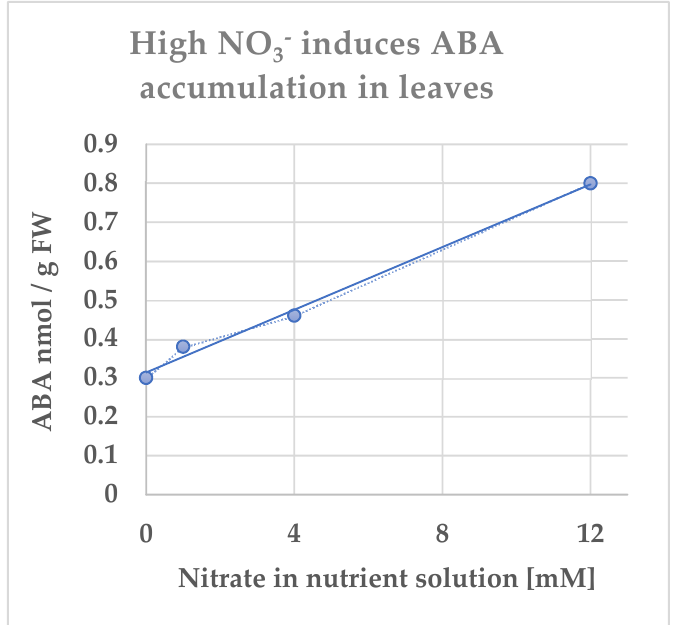
Figure 1. Concentration of ABA per fresh weight of leaves of Ricinus communis grown under different nitrate concentrations 41 d after sowing. Data are from A. Peuke (Personal communication), see also Peuke et al. [34].